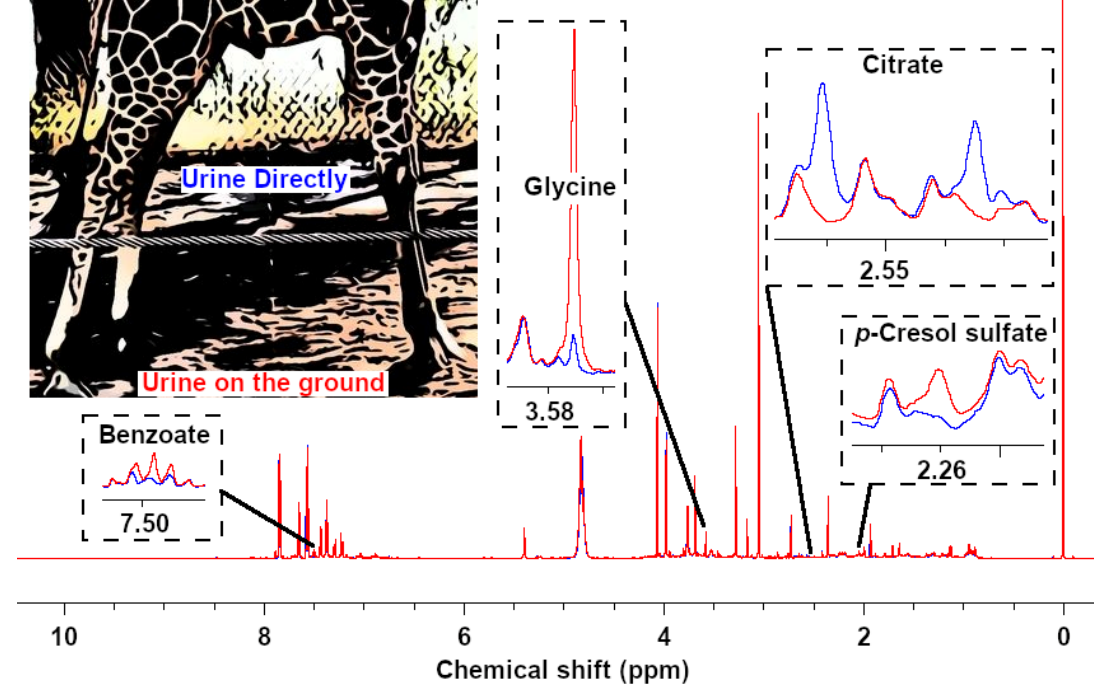
Figure 2. Representative sections of two spectra obtained from analyzing urine from the same giraffe (Ronny), collected directly (blue line) and from the ground (red line) during one urination, respectively.